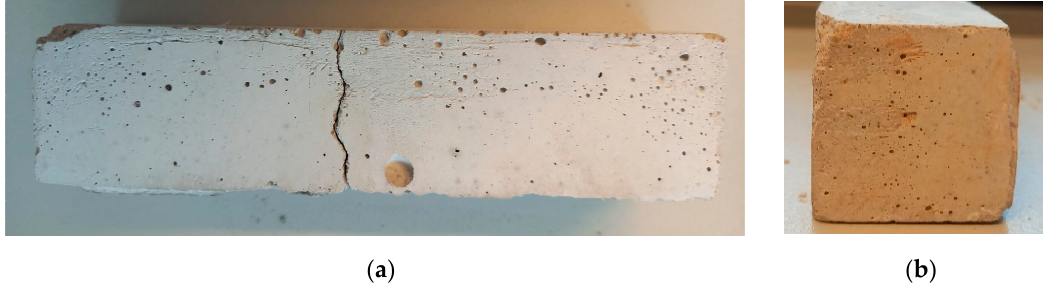
Figure 7. Portland cement-based binder CEM I 42.5R with 30% added ground slag from MSWI 1 incineration plant—after alkaline activation in 5M NaOH ( a ) front, ( b ) side.